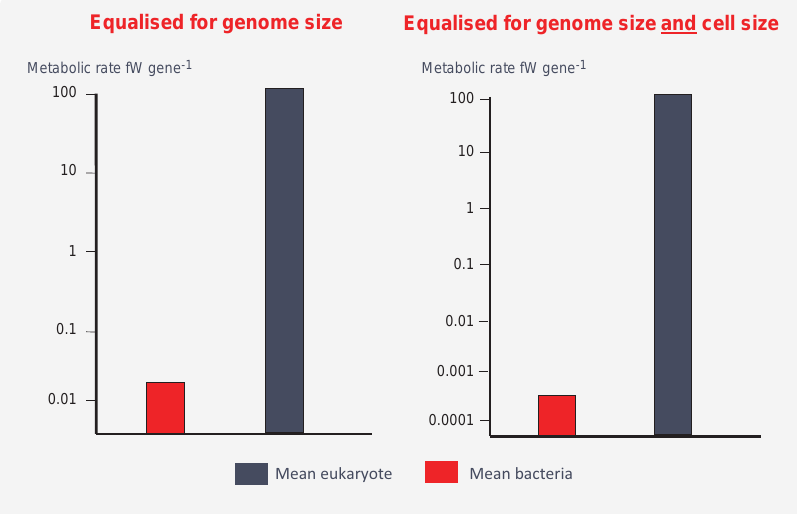
Figure 6. Energy availability per haploid copy of a gene, corrected for genome size (left) and cell volume (right). Data from Lane and Martin (2010), based on measured metabolic rates and mean genome sizes but scaled on the basis of an assumption that bacteria approximate to a sphere and respire across their plasma membrane only. Note the log scale on the Y